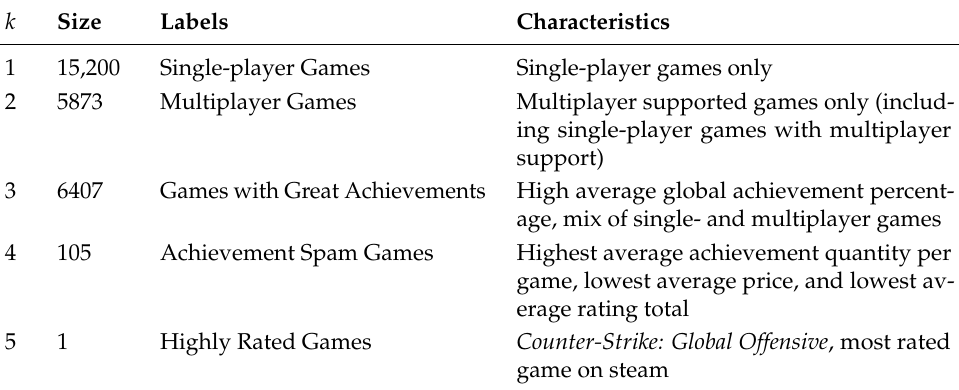
Table 6. Clustering results of the game data